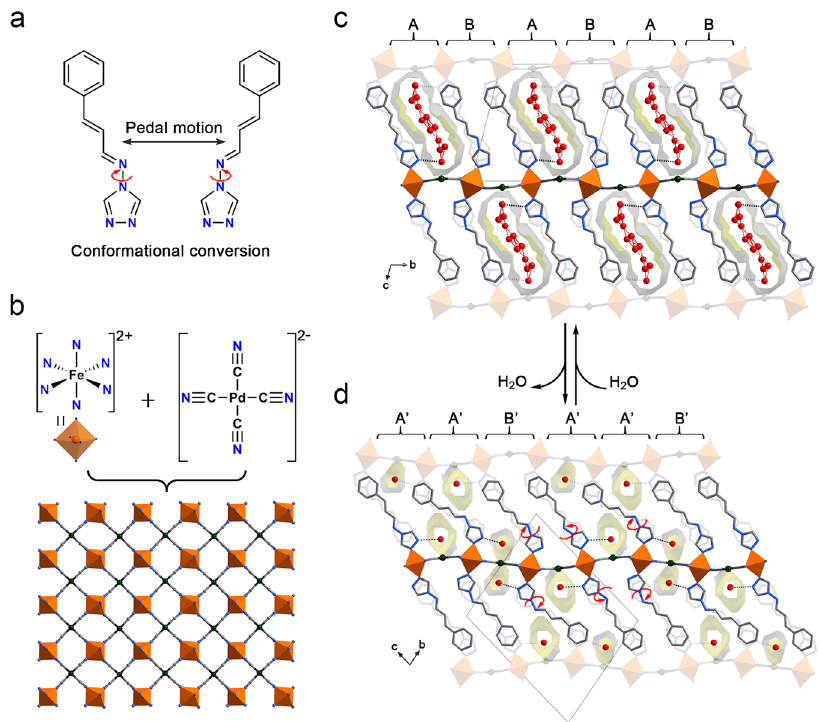
Fig. 2 Water adsorption-induced reversible single-crystal to single-crystal transformation. a The conformational fl exible prentrz molecules are employed as axial ligands. b The 2D network constructed from Fe − N( ≡ C − Pd) coordination bonds. The layer structures are further assembled into a 3D framework via interlaminar molecular interactions. c Single-crystal structure of the lcp phase 1 ·9/2H 2 O. d Single-crystal structure of the nqp phase 1 ·4/ 3H 2 O. The water adsorption-actuated reorientations and pedal rotations of the axial prentrz ligands repartition the lattice structure, manifesting as a narrow-pore to large-pore transformation accompanied by a rearrangement of the pore con fi guration from A ’ A ’ B ’ A ’ A ’ B ’ mode in nqp phase 1 ·4/3H 2 O to ABABAB mode in lcp phase 1 ·9/2H 2 O (A: open channel, B: closed channel). Therefore, the opening (A ’ /B ’ to A) and closing (A ’ to B) of pores coincide during water adsorption. According to SC-XRD analyses, 4/3 H 2 O and 9/2 H 2 O per Fe II ion accommodate in the pore of 1 ·4/3H 2 O and 1 ·9/2H 2 O, respectively. The dotted lines represent the hydrogen-bond interactions. Fe, orange; C, gray; N, blue; O, red. The hydrogen atoms were omitted for